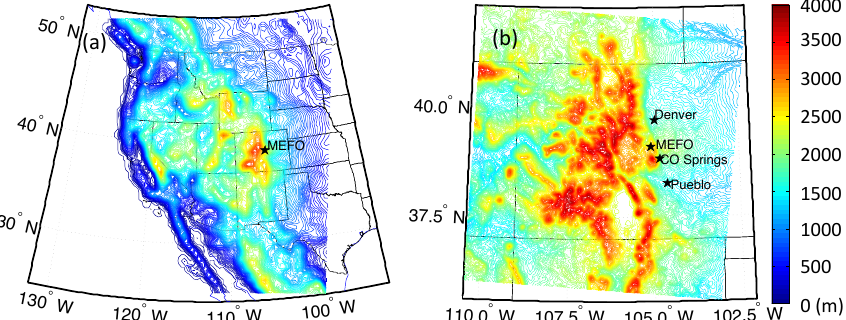
Figure 1. WRF-Chem domains. (a) Coarse domain covers the western US with 36 × 36km 2 horizontal resolution; (b) nested domain covers Colorado with 4 × 4km 2 resolution. Maps also show the topography, and the locations of the MEFO site, Denver, Colorado Springs, and Pueblo.